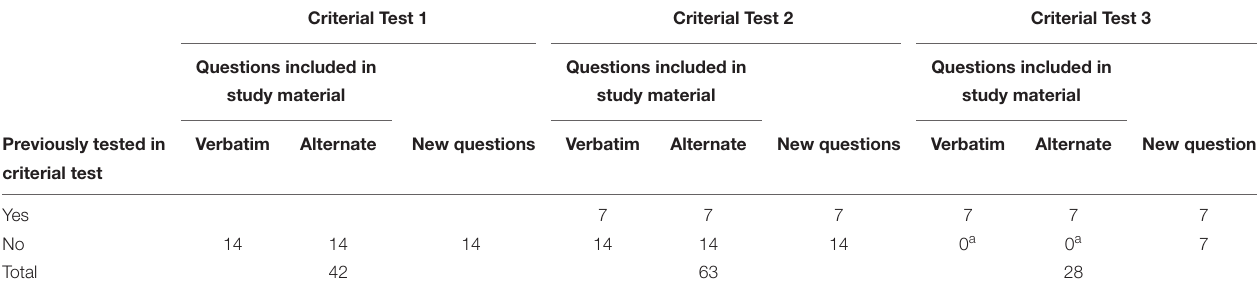
TABLE 1 | Criterial test composition by components and repetition of questions in later criterial